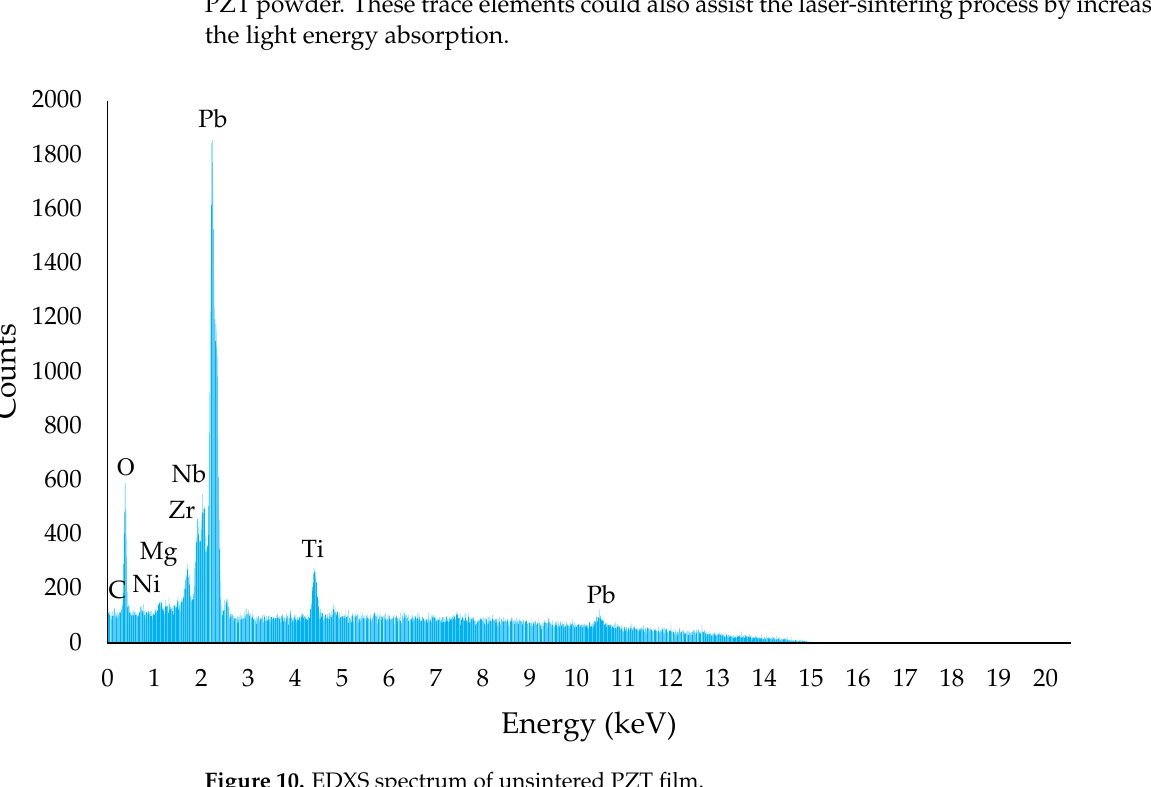
Figure 9. SEM images along the thicknesses of laser-sintered ( a ) PZT and ( b ) CNT/PZT.